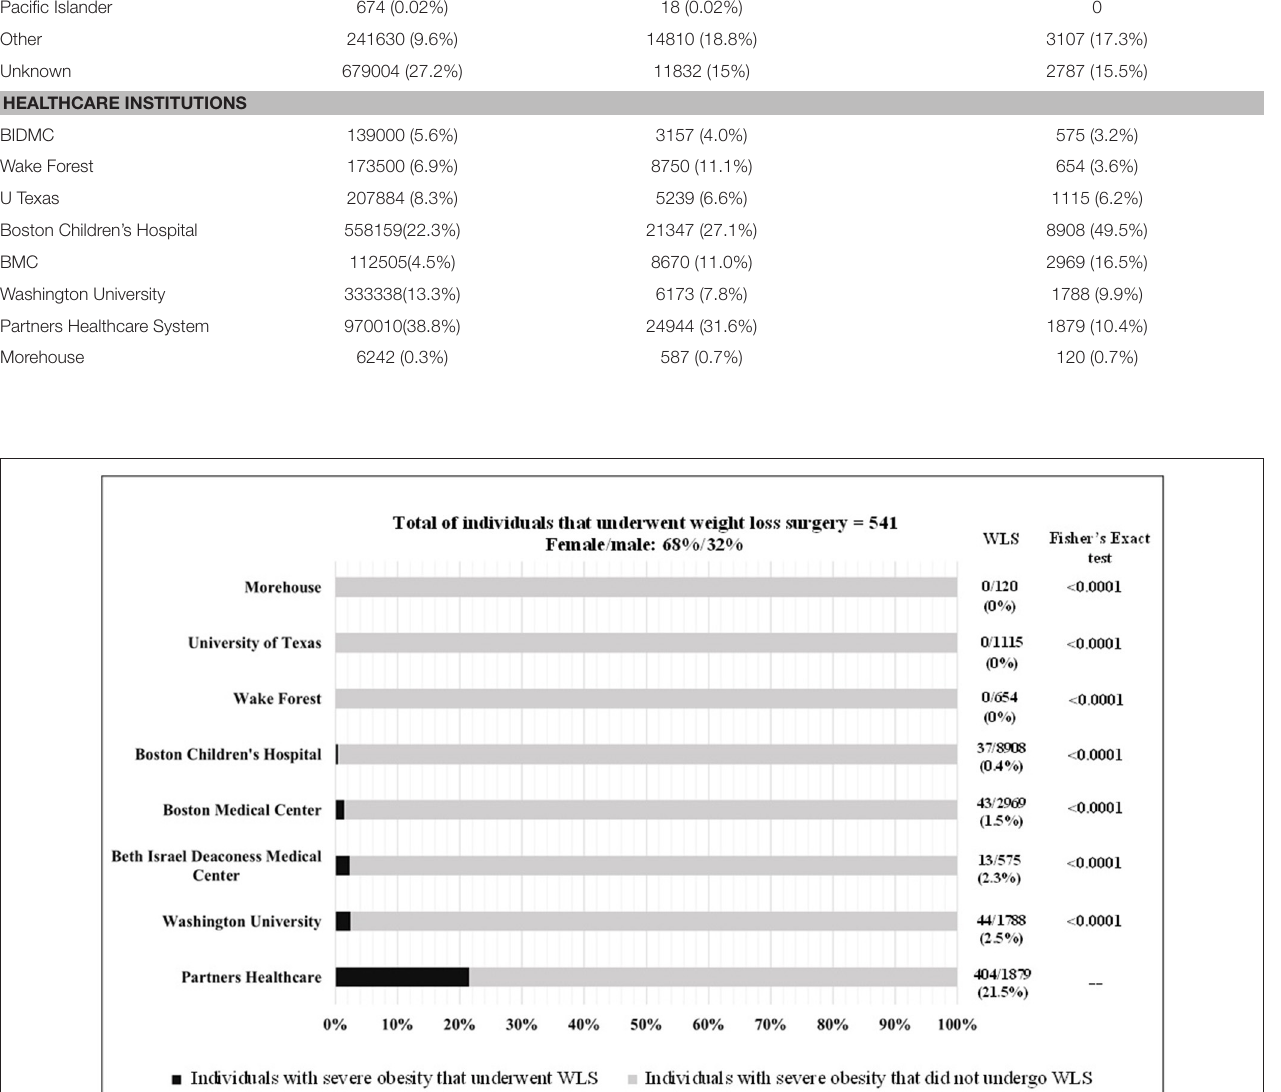
Frontiers in Pediatrics |